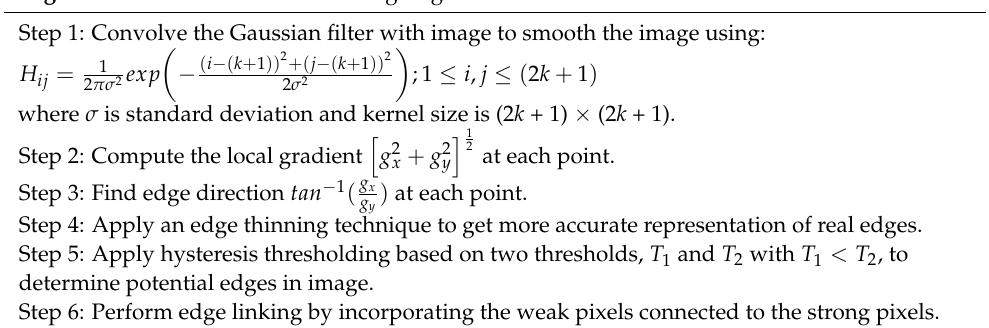
Algorithm 3: Feature Extraction using Edge Detection.